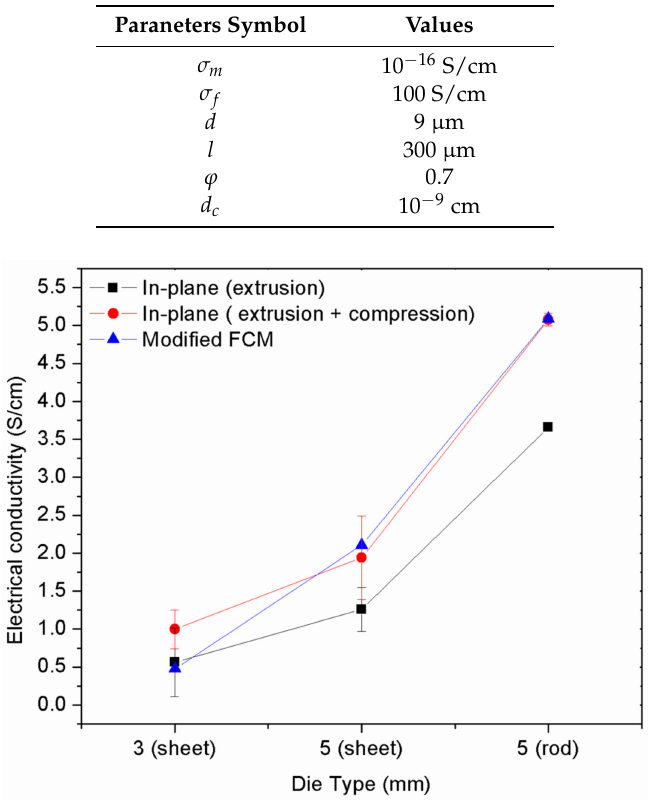
Figure 7. Electrical conductivity of extruded MCF/PP using the modified FCM